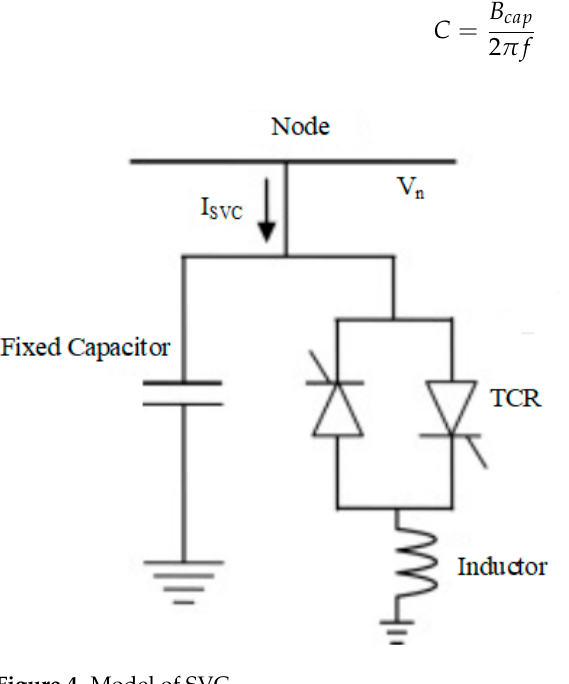
Figure 4. Model of Figure 4. Model of SVC.